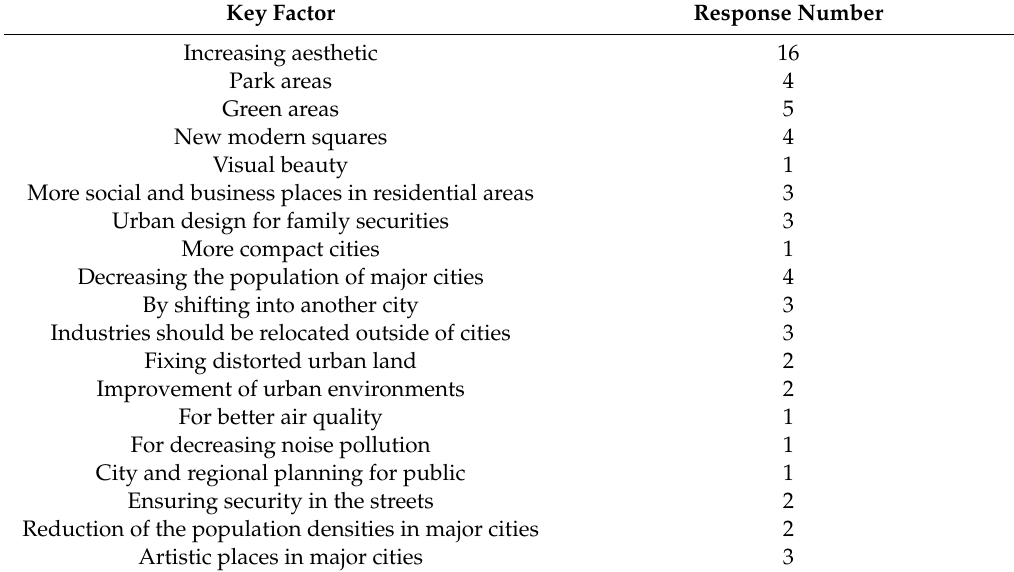
Table A5. Urban features.